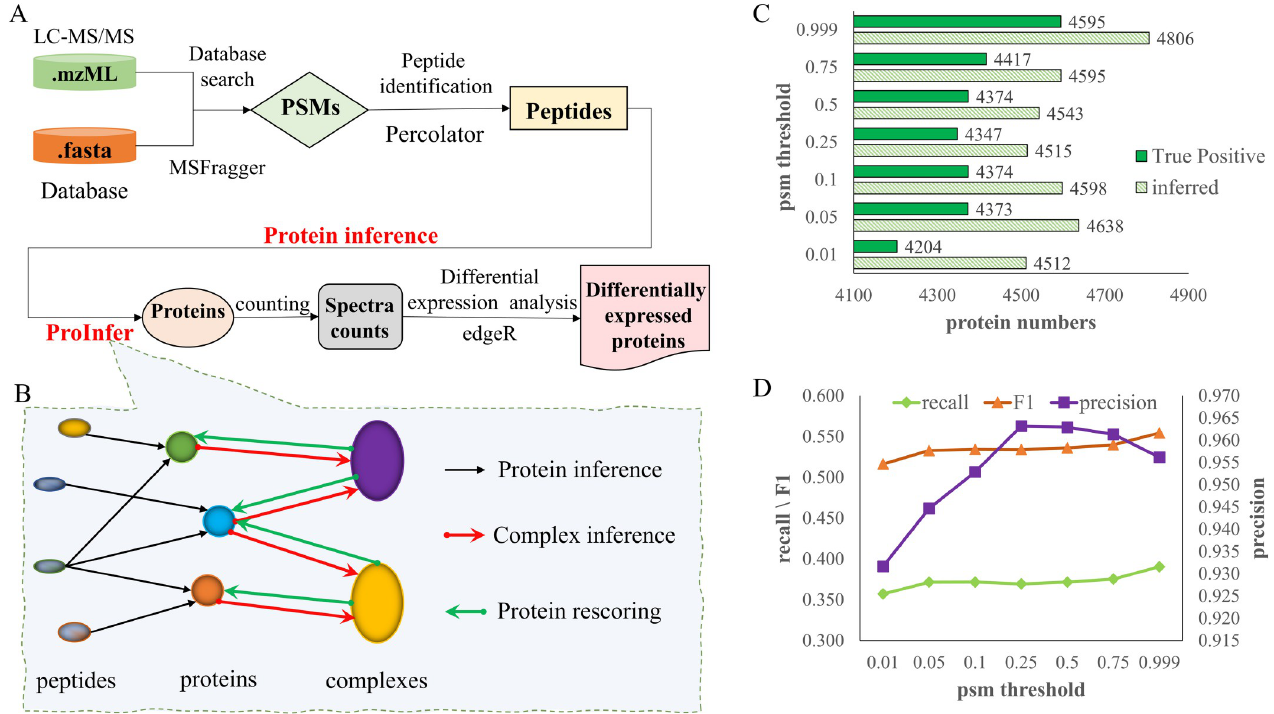
Fig 1. Workflow for protein inference and differential expression analysis with proteomic data and hyperparameter optimization results of proposed ProInfer. A shows a simple workflow of proteomics data-based protein inference and differential expression analysis. B gives a schema diagram of how ProInfer works. C presents the average inferred protein numbers and numbers of true positives found by ProInfer under different psm filtering thresholds (y- axis). The curves in D illustrate the performances of ProInfer indicated by recall, F1 (left-y axis) and precision (right-y axis) affected by various psm filtering thresholds